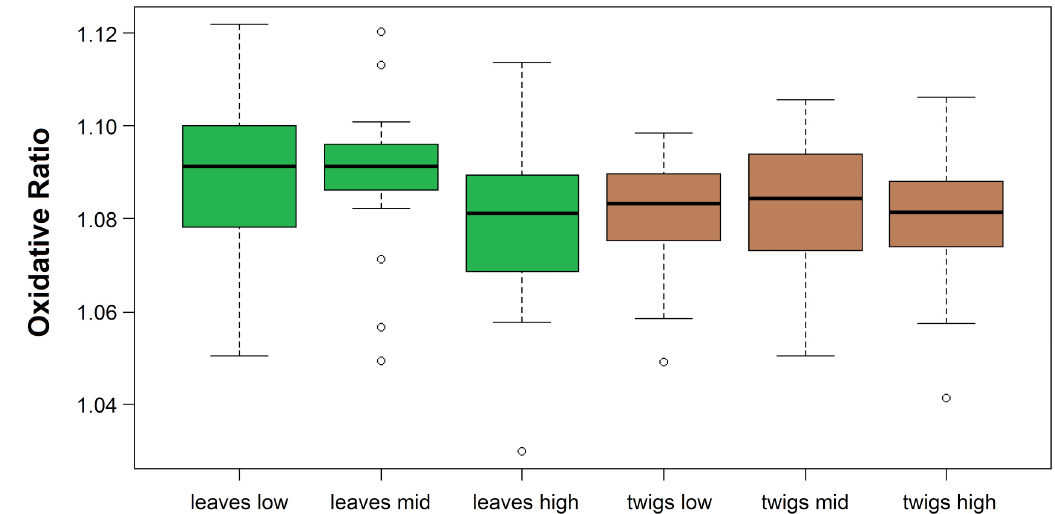
Figure 4. Boxplots of leaf and twig oxidative ratios separated by height (24, 28, 32 m), independent of the sampling date.